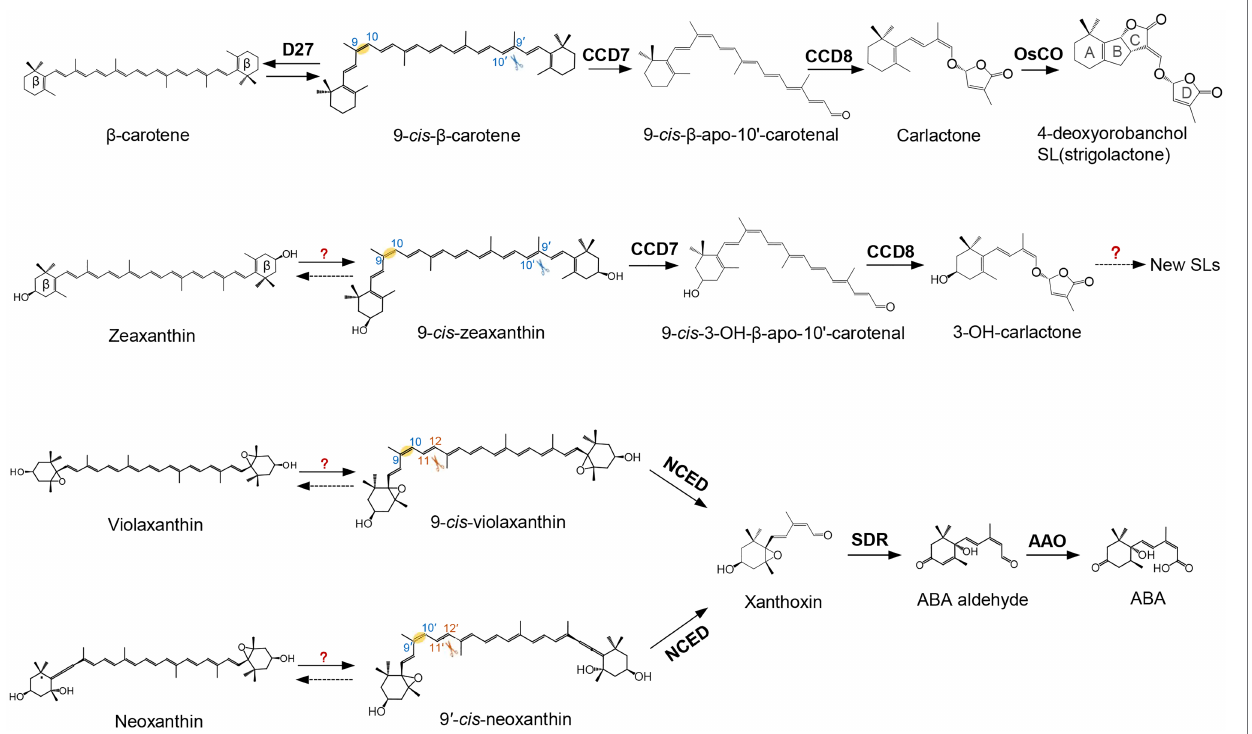
FIGURE 1 | Biosynthetic pathway of carotenoid-derived phytohormones. Names of carotenoids and apocarotenoids are shown in black. Names of carotenoid cleavage dioxygenases and apocarotenoid modifying enzymes are depicted in black boldface. D27 catalyzes the reversible isomerization of all- trans - β -carotene into 9- cis - β -carotene. 9- cis - β -carotene is then converted into strigolactones (SLs; 4-deoxyorobanchol is depicted as an example) by CCD7, CCD8, and CYP enzymes, such as the rice carlactone oxidase (OsCO), a homolog of the Arabidopsis MAX1. Violaxanthin and neoxanthin can be converted into 9- cis -violaxanthin and 9 ' - cis - neoxanthin, respectively. Nine- cis -Epoxycarotenoid Dioxygenases (NCEDs) cleave these two cis epoxy-xanthophylls to yield xanthoxin. Xanthoxin is then converted into abscisic acid (ABA) by short-chain dehydrogenase (SDR reductase) and abscisic aldehyde oxidase (AAO). Scissors indicate the double bond positions cleaved by carotenoid cleavage dioxygenase (CCD)